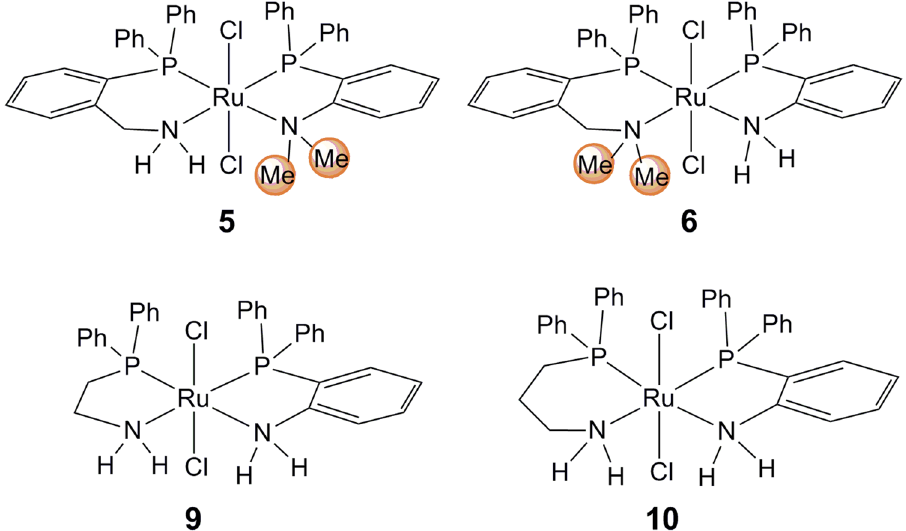
Figure 4. Structures of ruthenium complexes 5 , 6 , 9 , and 10 .